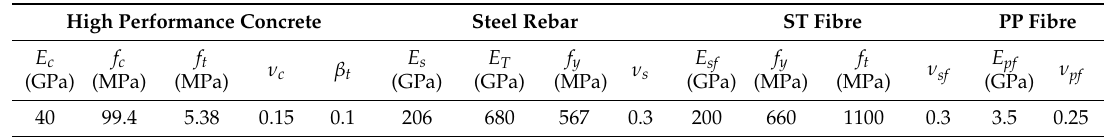
Table 3. Summary of material